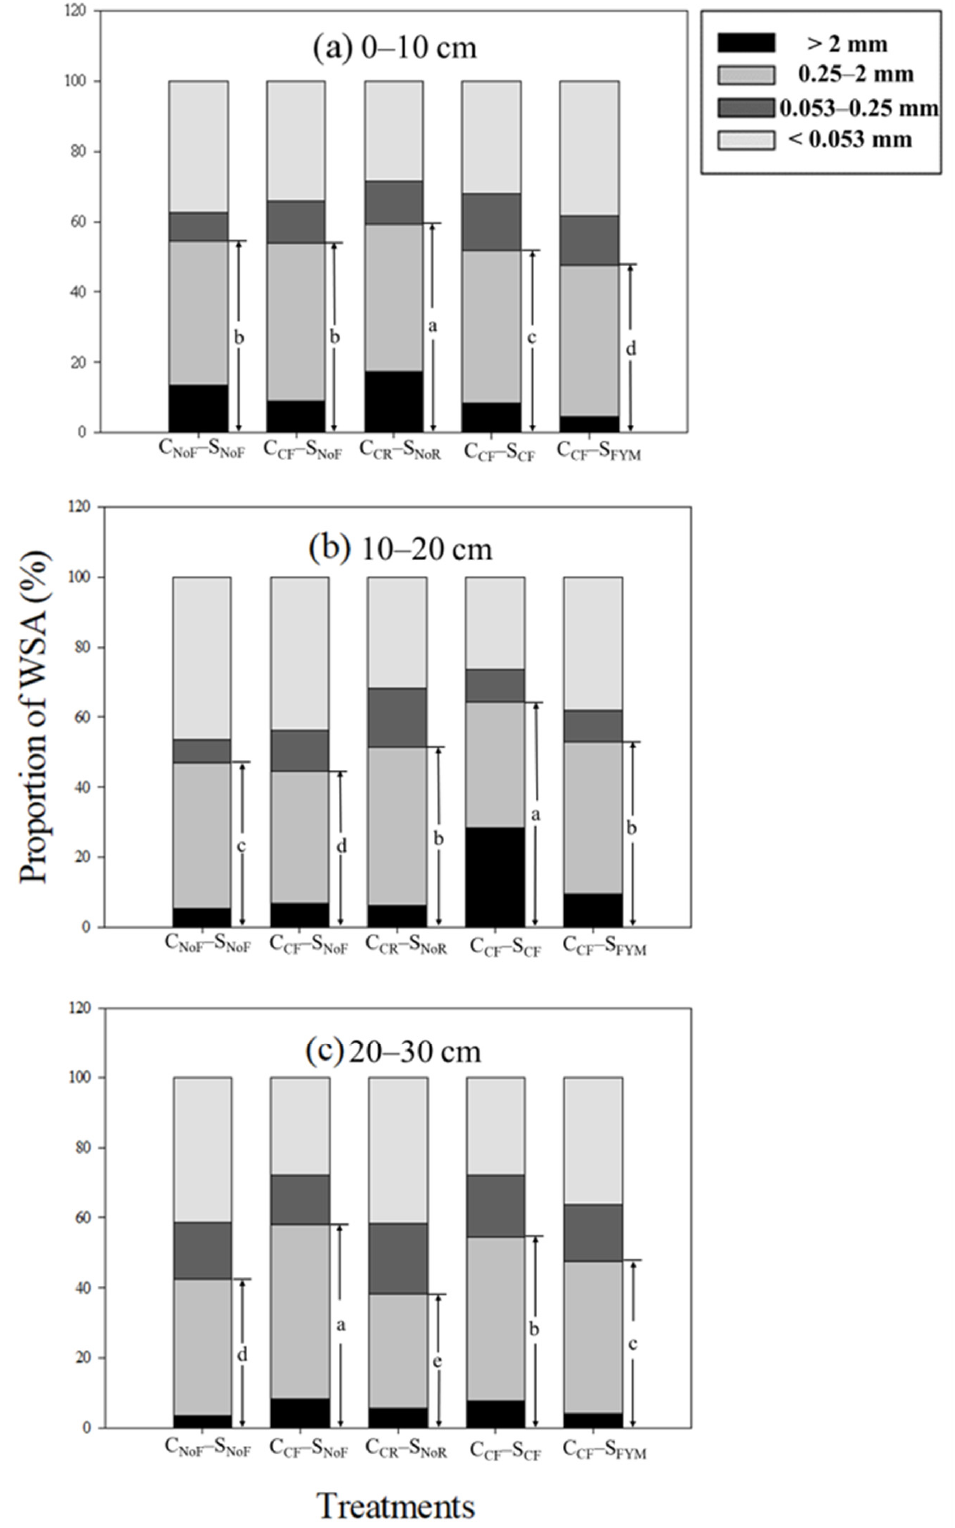
Figure 1. Size distribution (%) of water–stable aggregates. Note: Different lowercase letters represent significant differences in the proportions of macroaggregates (>2 mm and 0.25–2 mm) among different treatments at the same soil layer (Tukey’s HSD test, p < 0.05). Table 2. Size distribution proportion (%) of water–stable aggregates.